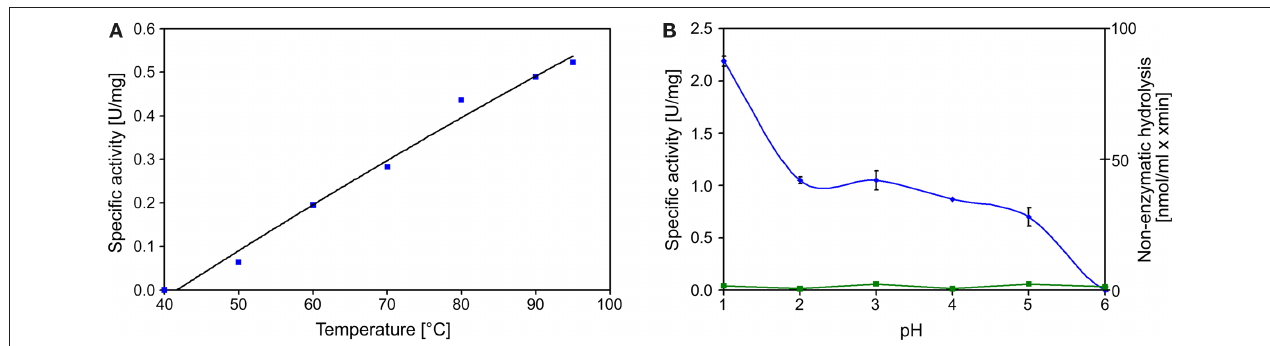
FiguRe 3 | Temperature and pH profiles of TTH activity. (A) Temperature profile of TTH activity from 40 to 95 ° C; (B) pH profile of TTH activity assayed at 80 ° C (blue line, left axis) and non-enzymatic TT hydrolysis (green line, right axis).